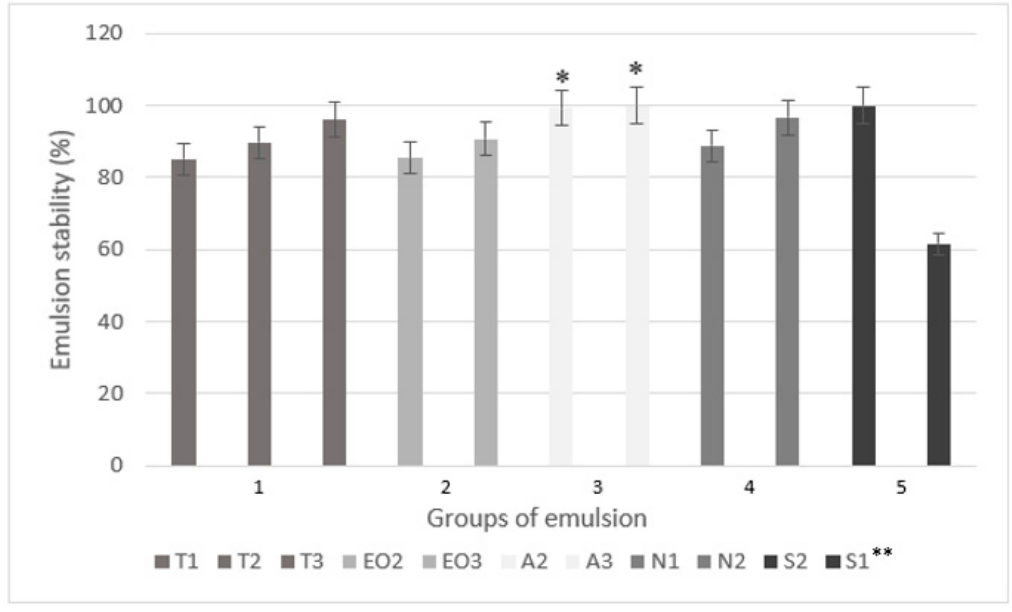
Figure 2. The emulsion stability (centrifugation index) using different amounts of excipients. * p < 0.05 vs. emulsion with a smaller amount of sodium alginate (T2). ** The code is given in Table 1.